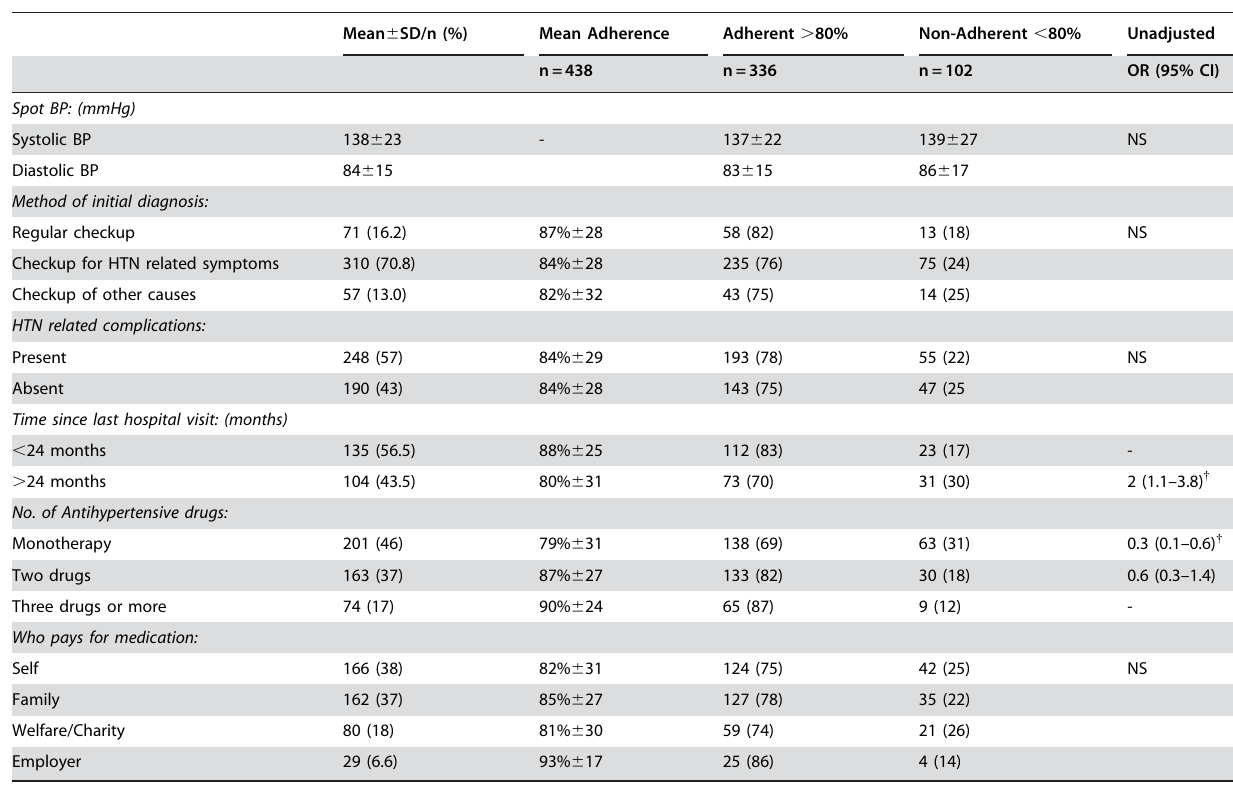
Table 2. Characteristics of hypertension and anti-hypertensive treatment .. ... .... ... ... .... ... ... .... ... ... .... ... ... .... ... ... .... ... ... .... ... ... .... ... ... .... ... ... .... ... ... .... ... ... .... ... ... .... ... ... .... ... ...